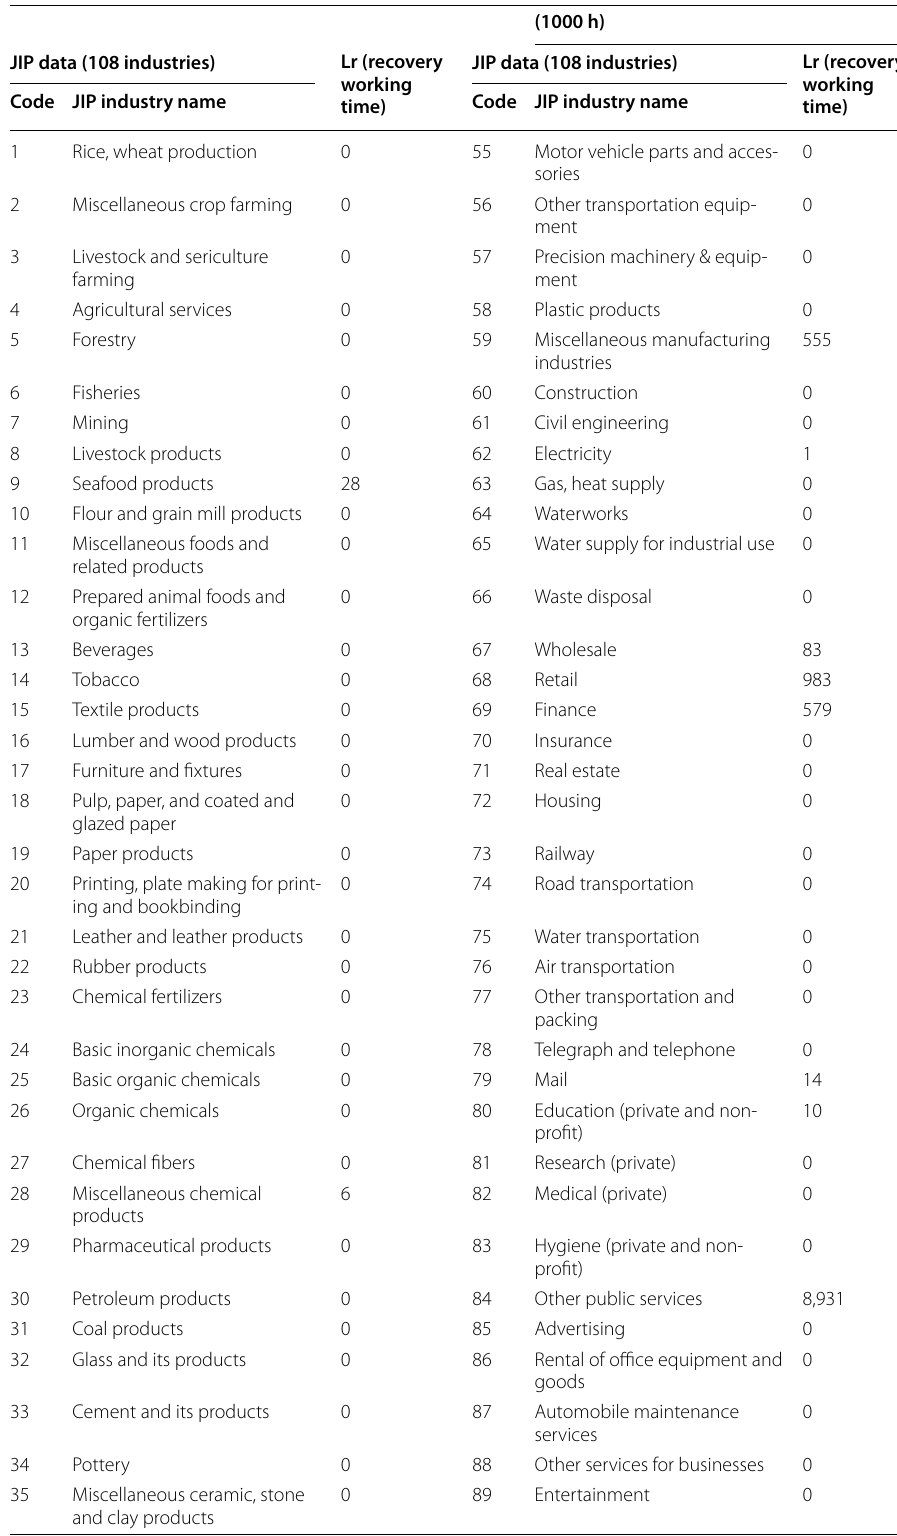
Table 2 Lr of 108